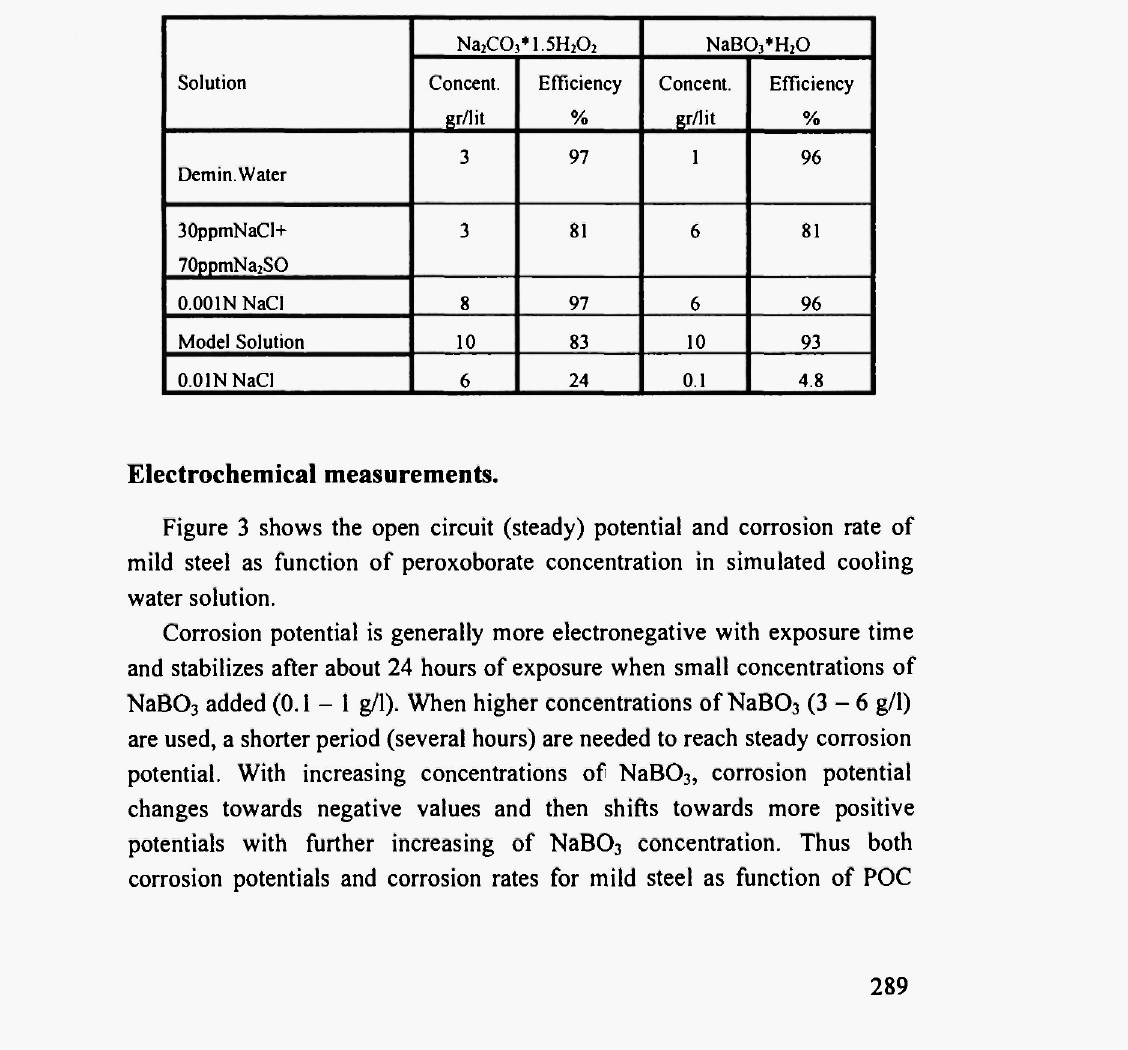
Maximum efficiencies of POC for mild steel in various